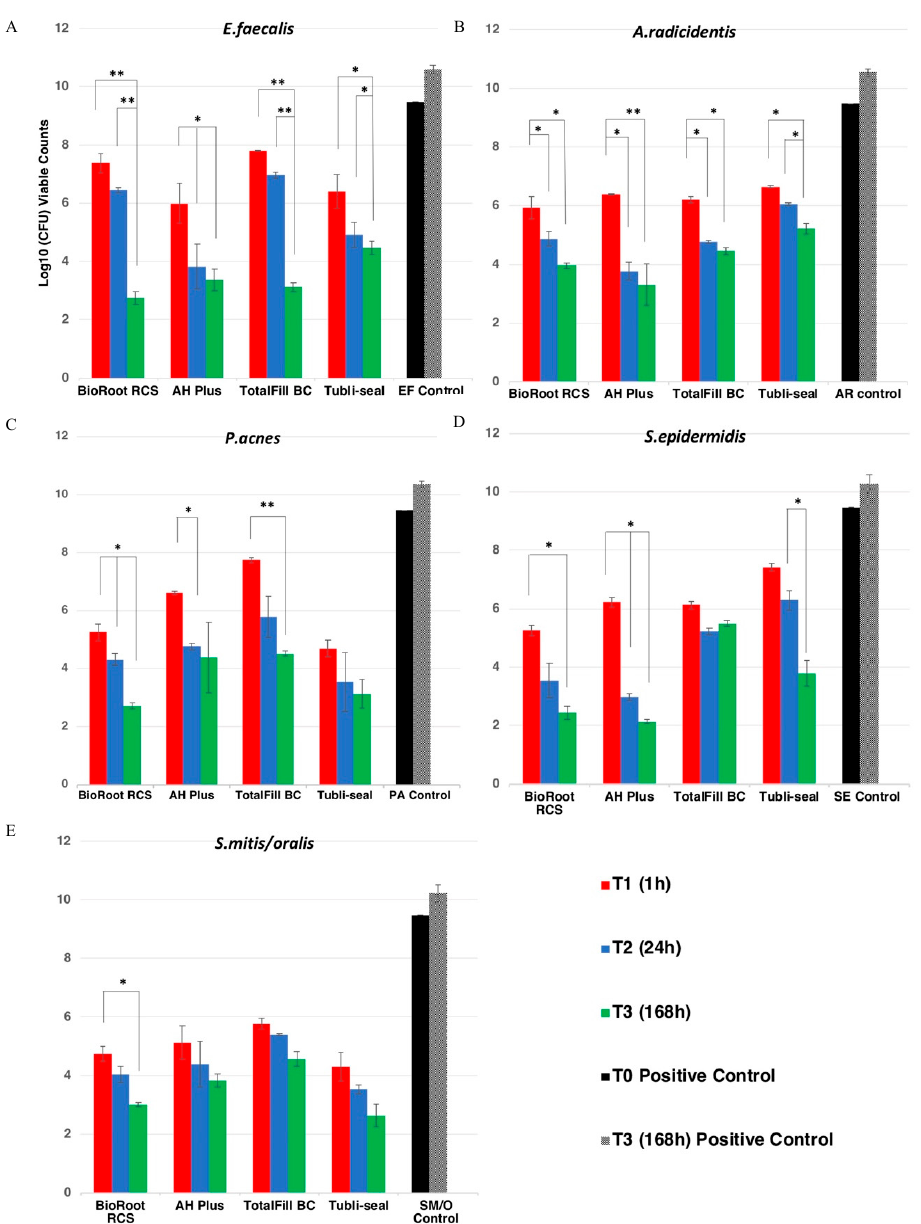
Figure 1. Quantitative viable counts of ( A ) E. faecalis (EF), ( B ) A. radicidentis (AR), ( C ) P. acnes (PA), ( D ) S. epidermidis (SE) and ( E ) S. mitis/oralis (Sm/o) following direct contact, comparing the effectiveness of each sealer groups at 1 h (T1), 24 h (T2) and 168 h (T3). Black columns represent the control for each bacterium, * ( p < 0.05), ** ( p < 0.01). The data are expressed as the mean number of bacteria (±standard error) as log10 (CFU per sample mL − 1 ). Negative control group presented nondetectable viable counts at all time points.